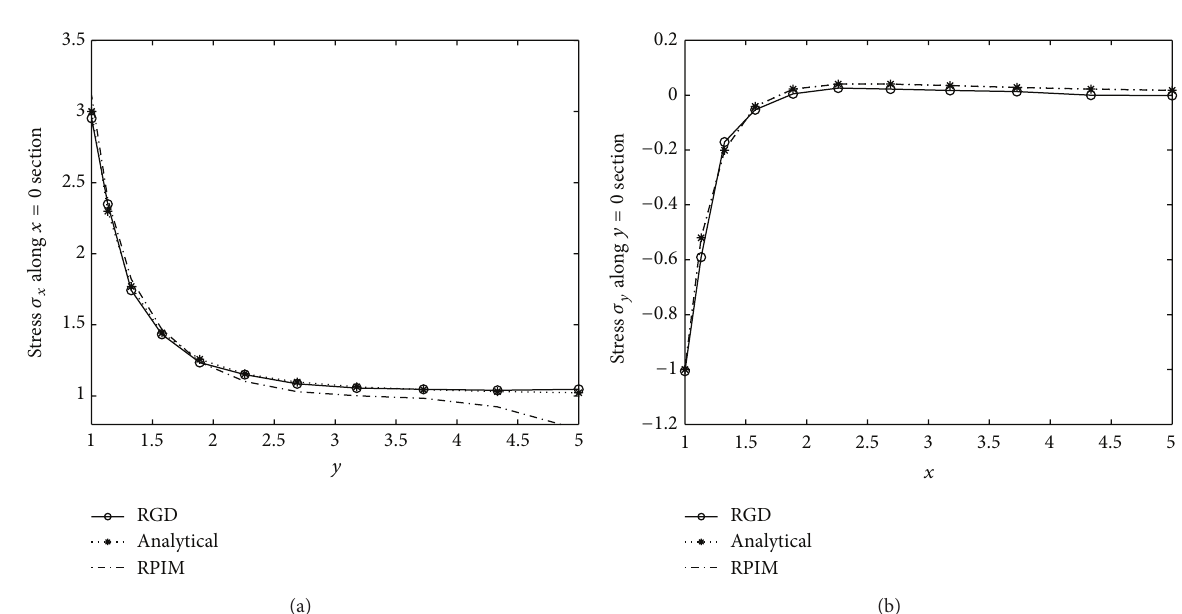
Figure 15: Comparisons of RGD and analytical solution: stress 𝜎 𝑥 at the stations along the left edge of the plate (a) and stress 𝜎 𝑦 at the stations along the bottom edge of the plate